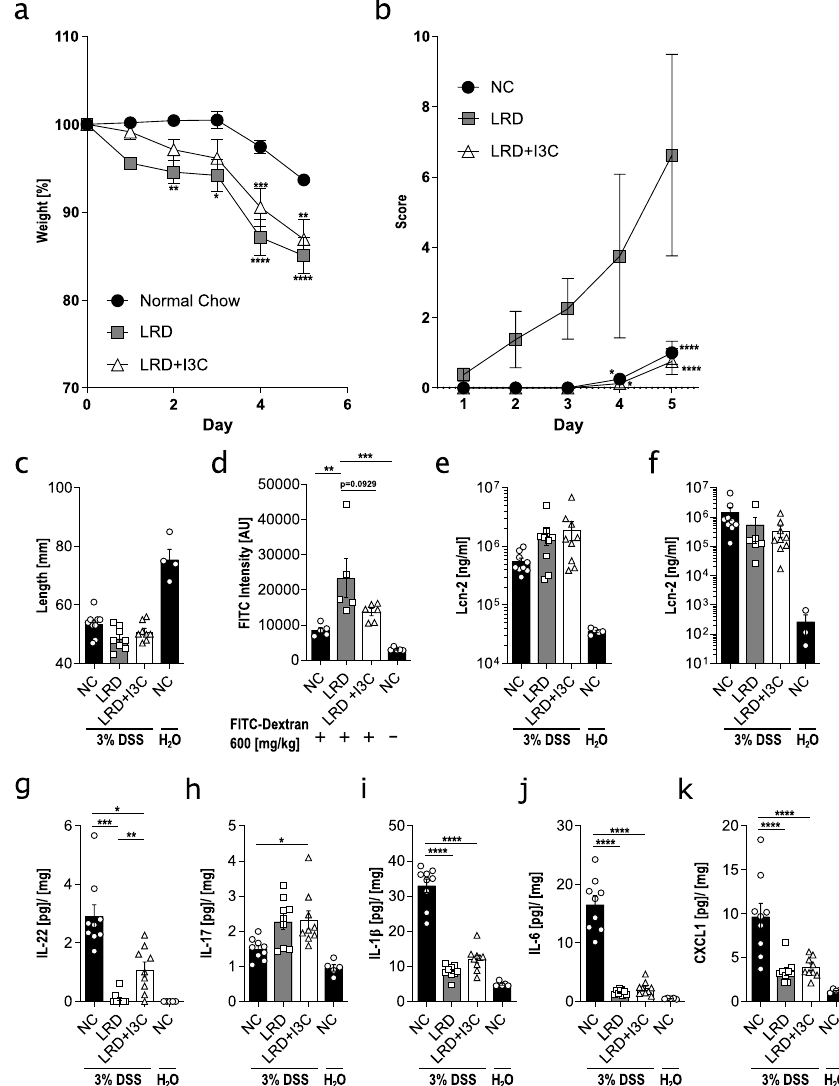
Figure 1. Dietary aryl hydrocarbon receptor (AhR) ligands influence the intestinal barrier integrity and susceptibility to dextran sodium sulfate (DSS)-induced colitis. C57BL/6 mice were fed for four weeks from weaning onwards with normal chow (NC), AhR ligand reduced diet (LRD), or LRD supplemented with indole-3-carbinol (LRD + I3C) (2 g/kg). Afterwards, mice were treated with 3% DSS via the drinking water for five days. Over the course of the experiment, body weight was monitored ( a ) and disease activity score ( b ) composed of general condition, spontaneous behavior, posture, and body weight was determined. ( c ) Colon length was measured at the end of the experiment. ( d ) Mice were fasted for four hours and orally gavaged with 600 mg/kg fluorescein isothiocyanate (FITC)-dextran, and FITC fluorescence in the serum was determined four hours later. Lipocalin-2 (LCN2) levels were measured in serum ( e ) and stool lysates ( f ) of DSS-treated mice and untreated control mice under different dietary conditions. Protein lysates of colonic tissue were analyzed for levels of interleukin (IL)-22 ( g ), IL-17 ( h ), IL-1β ( i ), IL-6 ( j ), and CXCL1 ( k ). Data are pooled from at least two independent experiments ( n = 3–17). Results are shown as mean +/− SEM and significance was analyzed by ordinary one-way analysis of variance (ANOVA) or two-way ANOVA (a/b) (* p < 0.05, ** p < 0.01, *** p < 0.001, **** p < 0.0001).